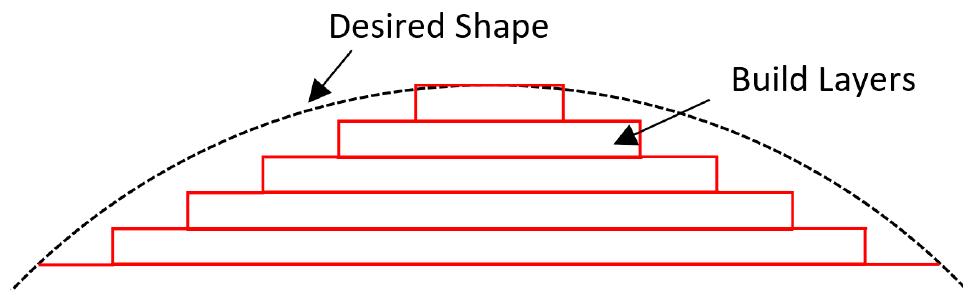
Figure 5. A schematic of the Stair Casing Effect that has been shown in AM